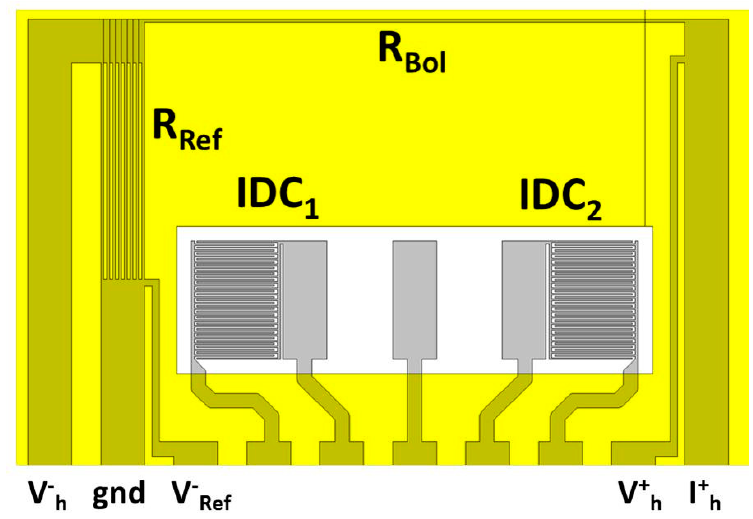
Figure 2. Example for a chip layout with interdigital capacitors IDC for electric impedance spectroscopy and a heater structure R Bol for measuring the thermal conductivity using the 3 ω voltage caused by its heat modulation. The same AC current flows through R Bol and a much lower reference resistor R Ref so no heat modulation occurs here. Temperature changes of the chip affect both resistors and are thus compensated automatically.